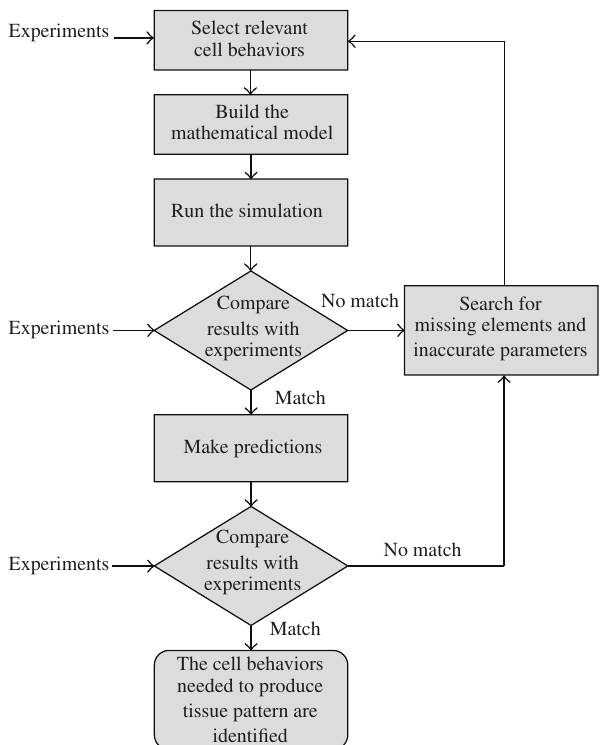
FIGURE 1: Flow chart illustrating a typical protocol to build and validate a cell-centered model [30].